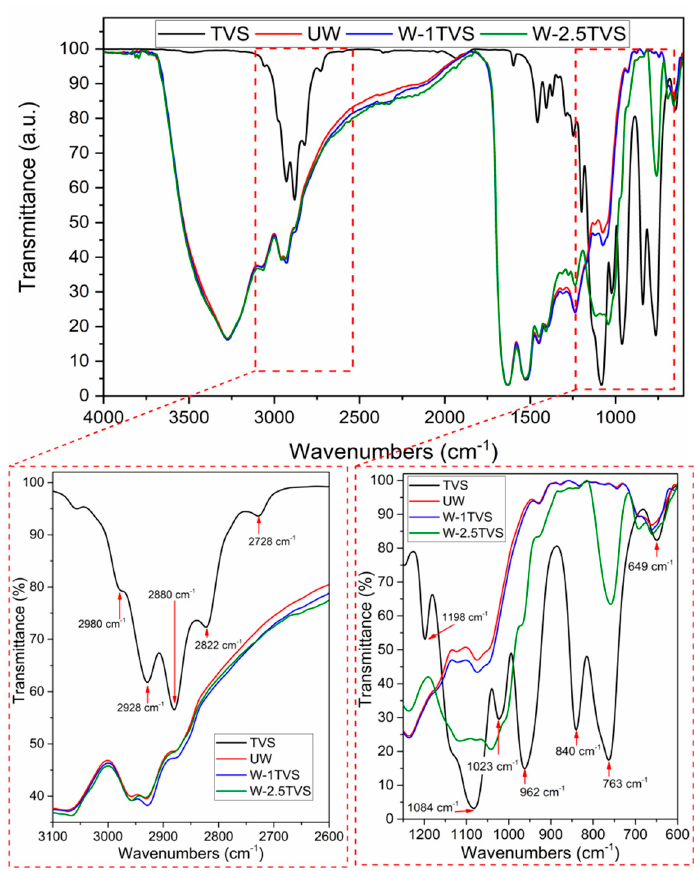
Figure 3. FTIR spectra of TVS and studied untreated wool (UW) and wool treated with different TVS concentrations.